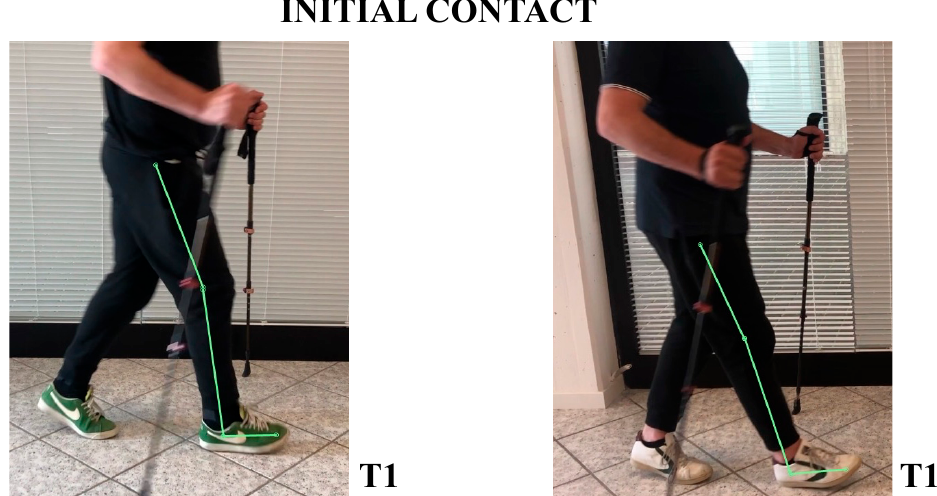
Figure 5. Initial contact frames at initial ( T1 ) and final ( T10 ) evaluation; with RAGT training, the patient gained a better alignment of the trunk and lower limb, with the onset of a real “heel strike” to the ground .